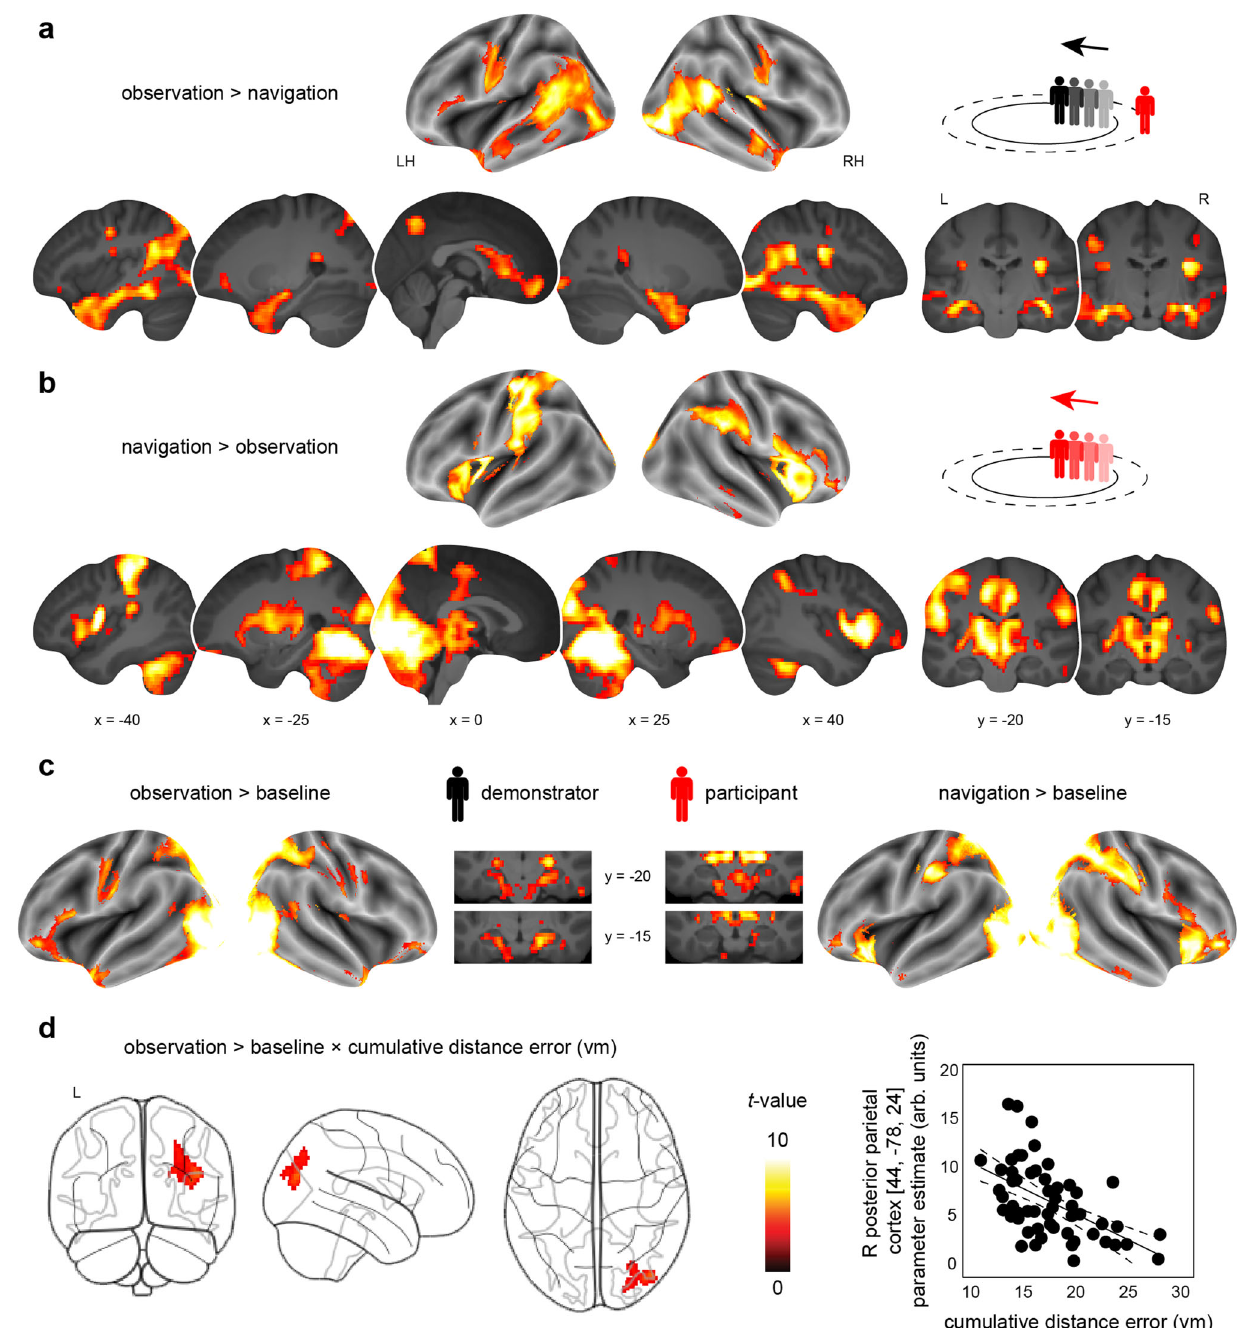
Fig. 2 | Brain activation pro fi les during observation and navigation, and asso- ciation with performance. Brain activation a during observation (compared to navigation) periods, and b vice versa (separate one-sample t -tests, N =58; Supple- mentary Table S1). c Brain activation changes when contrasting each condition against the implicit ( fi xation) baseline (separate one-sample t -tests, N =58;seealso Supplementary Fig. S2, Supplementary Table S1). d Brain activation during obser- vation (compared to implicit baseline) and association with performance across participants (indexed by the average cumulative distance error in virtual meters,